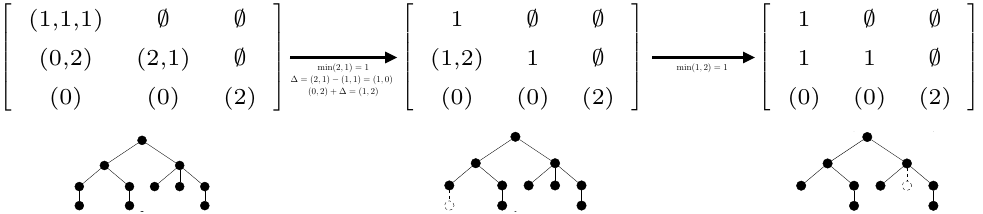
Figure 14. Progress of Algorithm 3 to compute the NeST of the left tree from its height profile. Only the second line must be edited to get the correct output. Editions of the height profile are associated with deletion of vertices in dashed lines. The output tree is self-nested and has been constructed by removing a minimal number of nodes from the initial